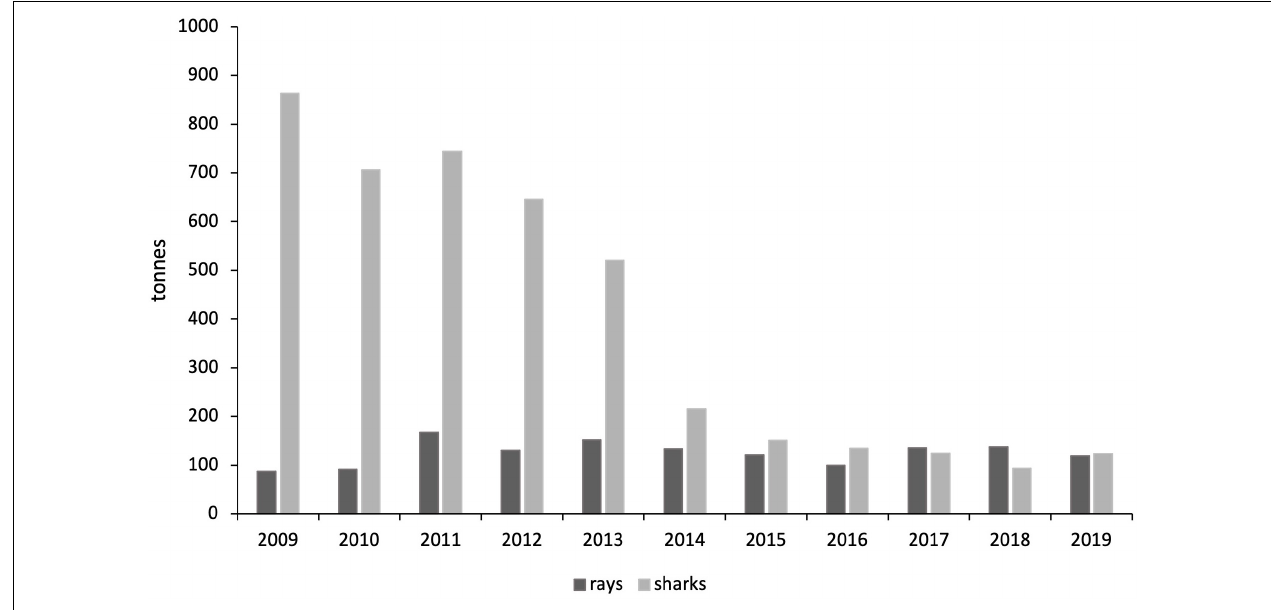
FIGURE 1 | Official landings of elasmobranchs in Sesimbra fishing port from 2009 to 2019.